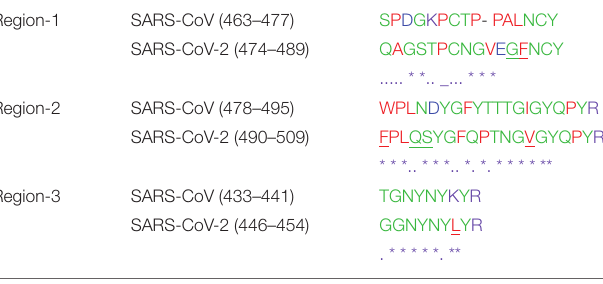
TABLE 2 | Sequence comparison between modeled SARS-CoV-2 RBD-ACE2 complex and chimeric ACE2-RBD of SARS-CoV. Region-1